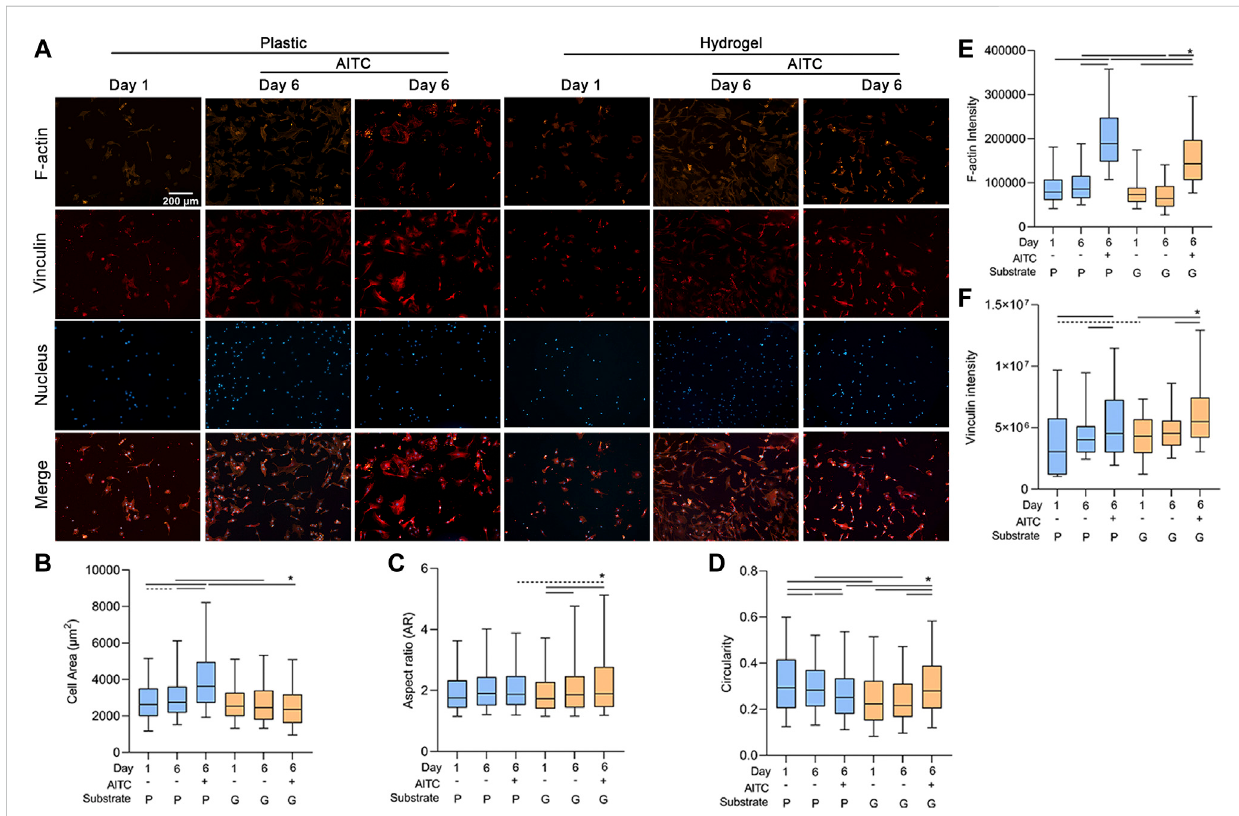
FIGURE 3 TRPA1activation regulatedtheshapeandF-actincytoskeletonofCHs.CHsweredividedintotwogroups:onewasculturedonplasticandtheother was cultured on hydrogel. Each group was then sub-grouped into three: 1-day culture, 6-day culture, and 6-day culture with AITC treatment. (A) Representative images of F-actin, vinculin, and nucleus staining of CHs, and the quantitative analysis of (B) cell area, (C) AR, (D) circularity, (E) F-actin intensity, and (F) vinculin intensity. Results are expressed using the boxplots ( n = 80 – 200 cells). Repeated measures ANOVA followed by Dunnett ’ s post-testwasusedinthestatisticalanalysis,anda t -testwasalsoappliedwhenthedifferencewasnotsigni fi cantwiththeANOVAtest.Thedifferencesare considered statistically signi fi cant at p < 0.05. (P: plastic, G: hydrogel; line: line on the top of the boxes points to the compared objects with ANOVA, dot line: test with t